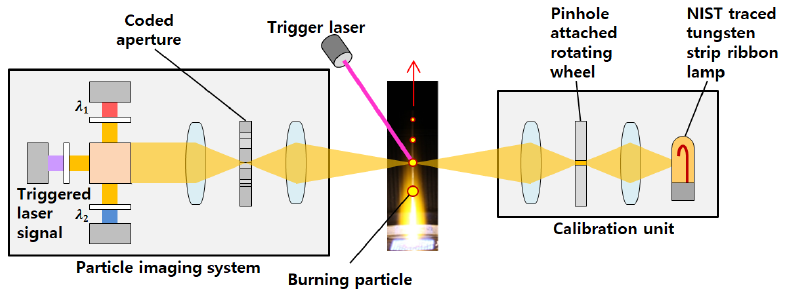
Figure 3. Schematic of the burning particle temperature-measuring system: